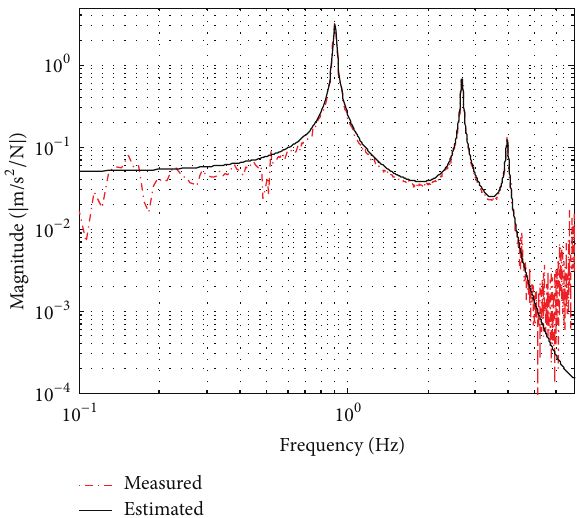
Figure 13: Comparison of the magnitude of frequency response functions (accelerances) for the third floor acceleration.